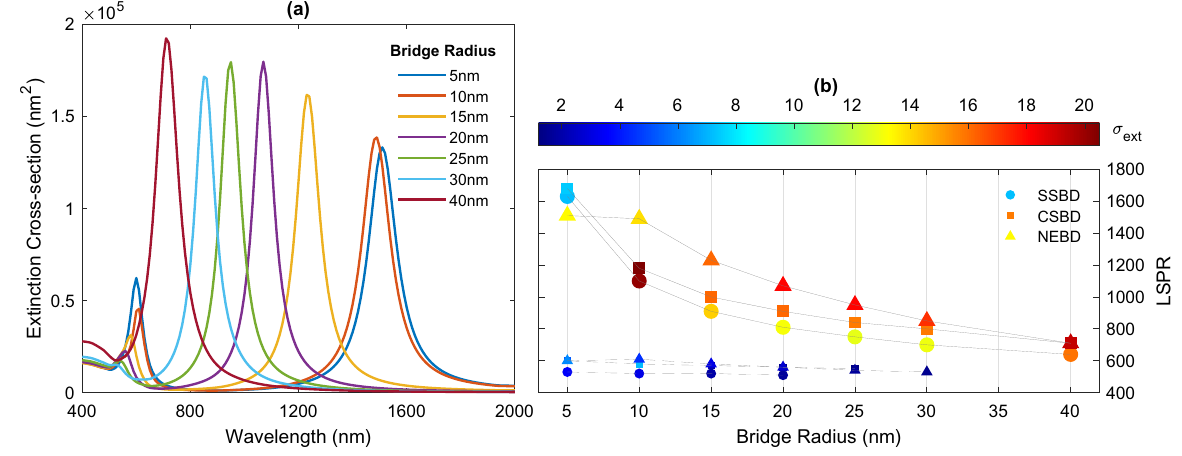
Figure 9. ( a ) Extinction spectra of NEBDs with different bridge radius. ( b ) Variation of resonance modes and their intensity by the radius of the bridge. Solid and dashed lines relate to CTP and SBDP modes, respectively.